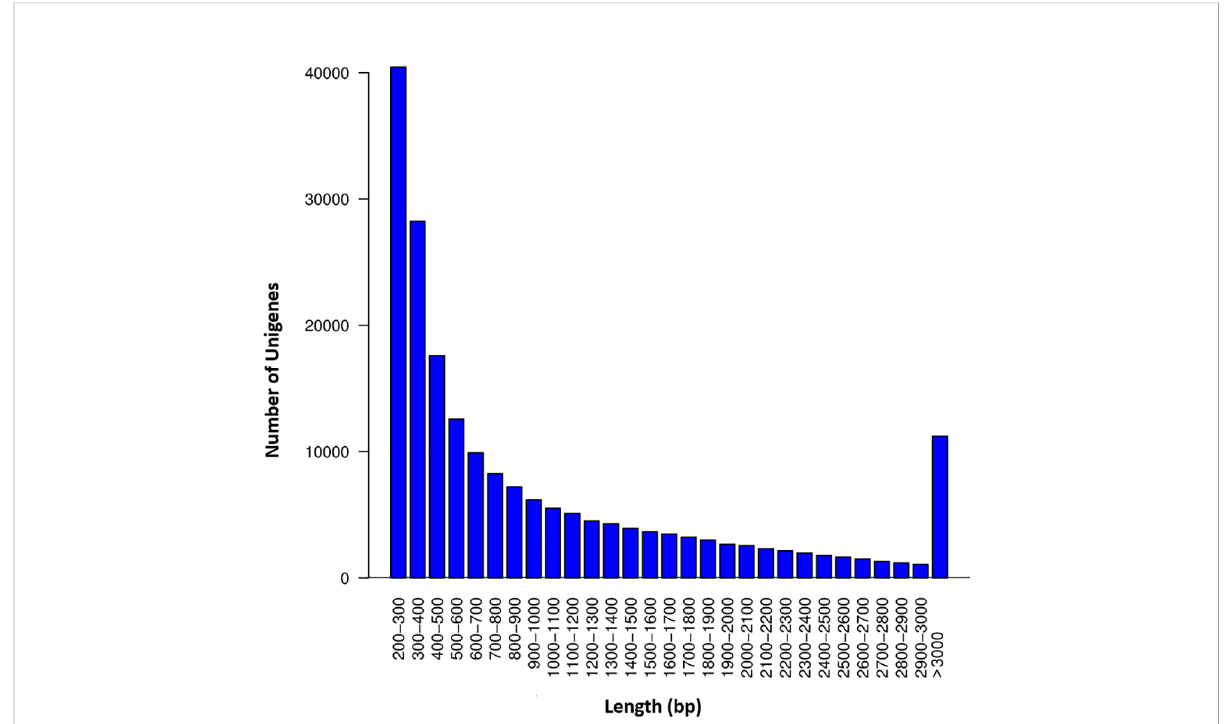
FIGURE 2 Sequence length distribution of the unigenes. The X-axis represents the length of the unigenes in ranges whereas the Y-axis represents the number of unigenes in each range.